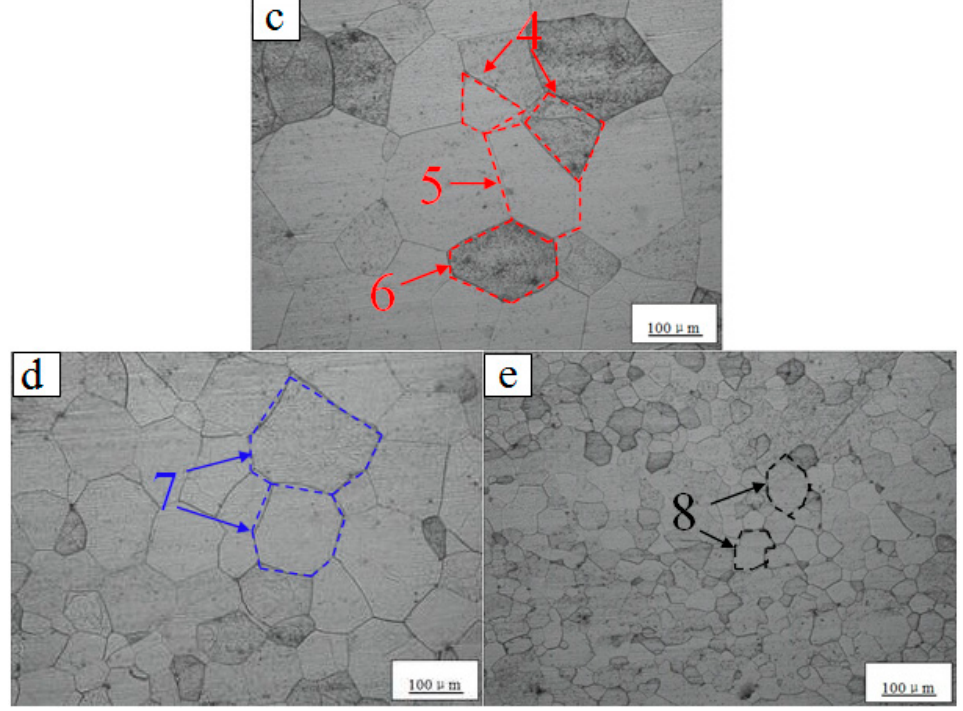
Figure 10. ( c ) the microstructure of point c in Figure 7; ( d ) the microstructure of point d in Figure 7; ( e ) the microstructure of point e in Figure 7.